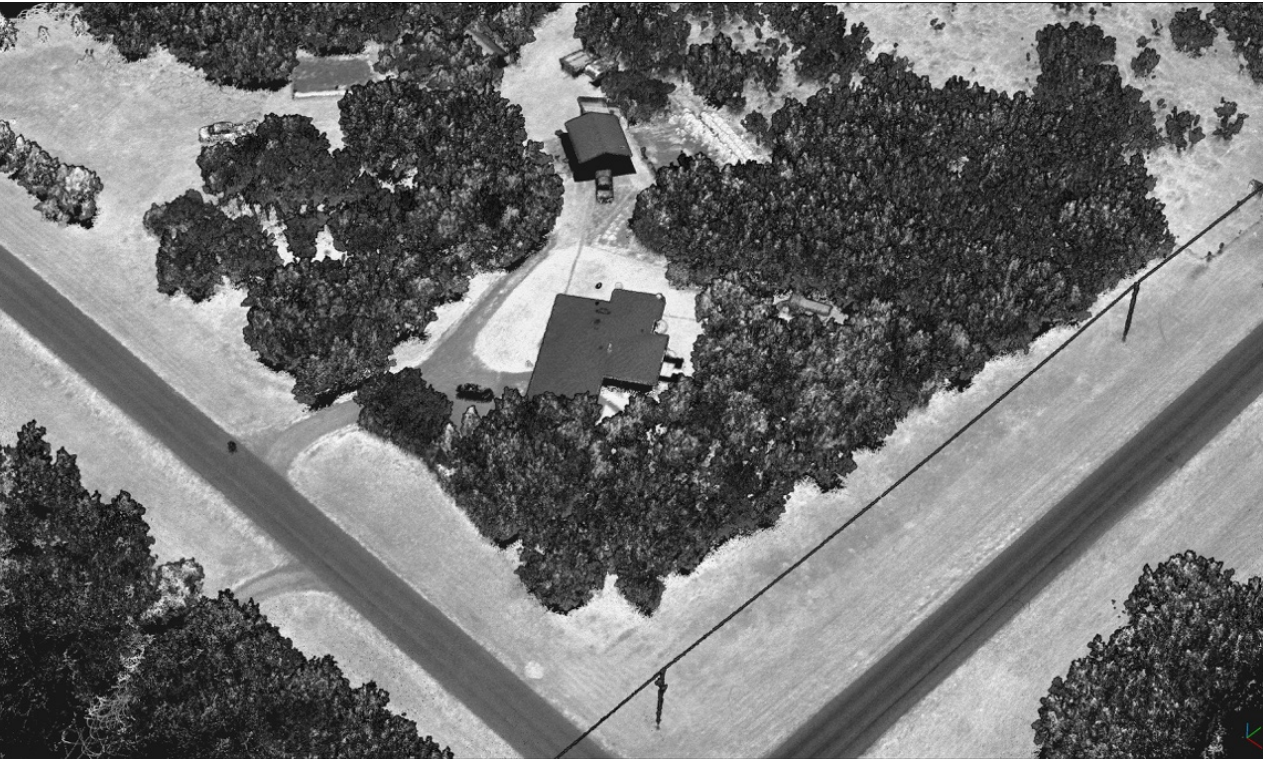
Figure 13. North–west looking-perspective view of the point cloud for flight A, colored by gray-scale intensity values. Figure 14 illustrates the horizontal position differences between the single and dual- antenna generated point clouds based on the points within the five regions of the Mid-40 ′ s FoV. In the figure, note that the heading precisions for the single-antenna GNSS/INS trajectory are shown as the top dashed line and reference the secondary vertical axis.